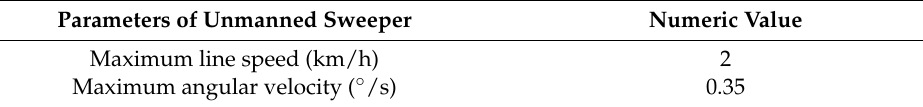
Figure 12. Unmanned sweeper for the experiment. Table 2. Movement parameters of unmanned sweeper.